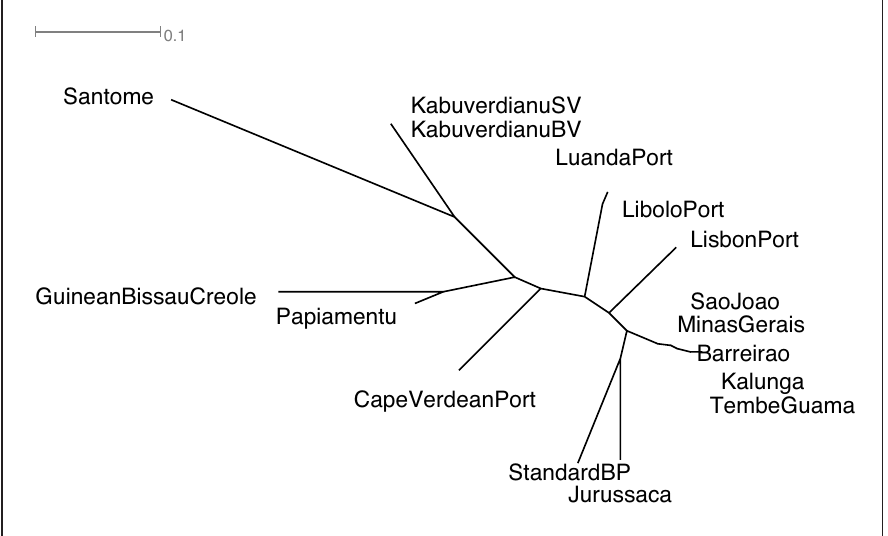
Figure 4: Split tree of a Neighbour-Joining Tree based on 48 Typological features, adapted from APICS/WALS of 16 language